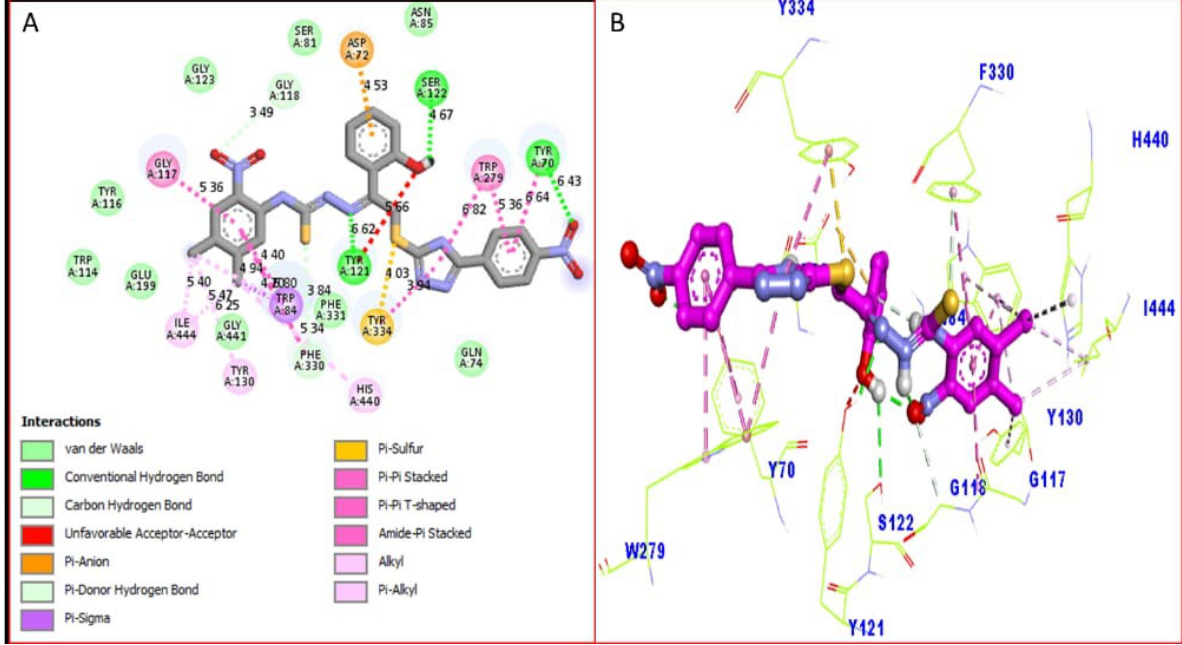
Figure 7. Protein–ligand interaction (PLI) profile of analogue 6b against acetylcholinesterase (AChE): ( A ) 2D; ( B ) 3D.